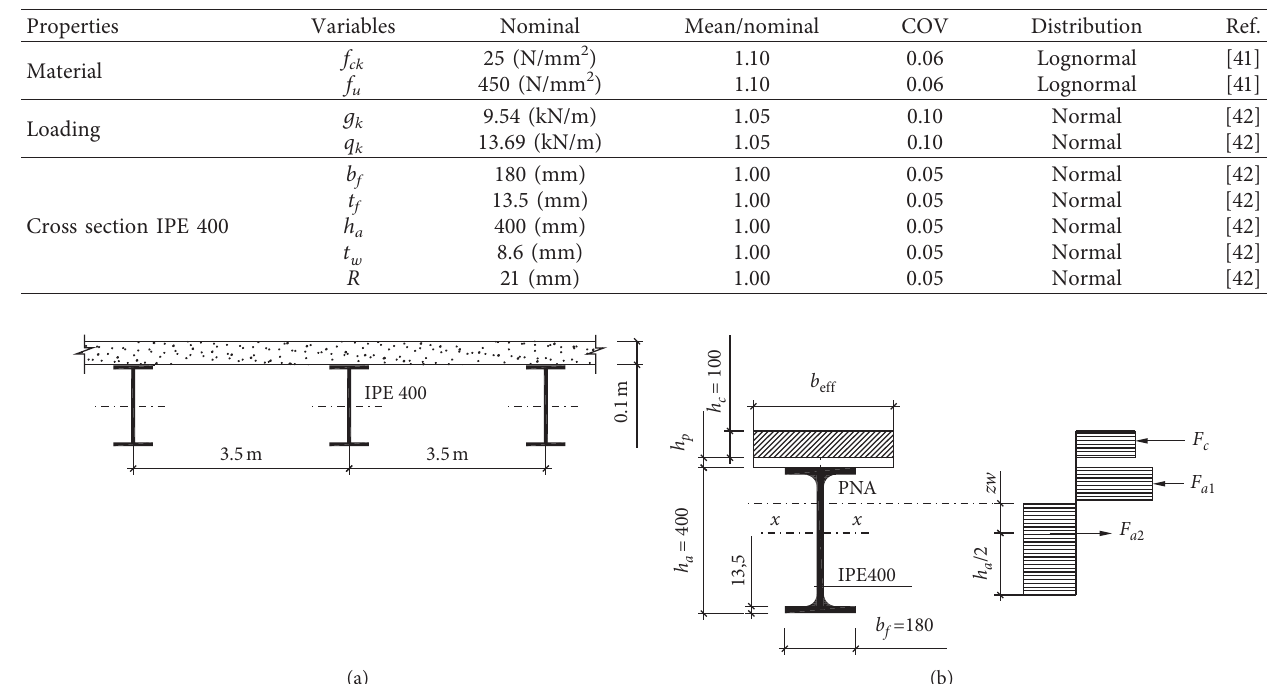
Table 5: Statistical properties of random variables for reliability assessment of SCC beams.